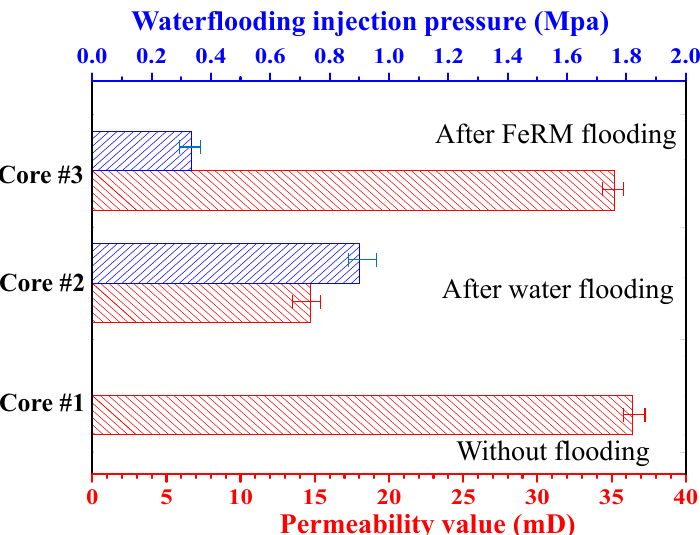
Figure 5. Effects of the permeability and waterflooding injection pressure in the cores by FeRM action. Core #1 (blank control, without flooding); core #2 (experimental control, waterflooding, without FeRM ) ; core #3 ( experiment, 5% of FeRM flooding).